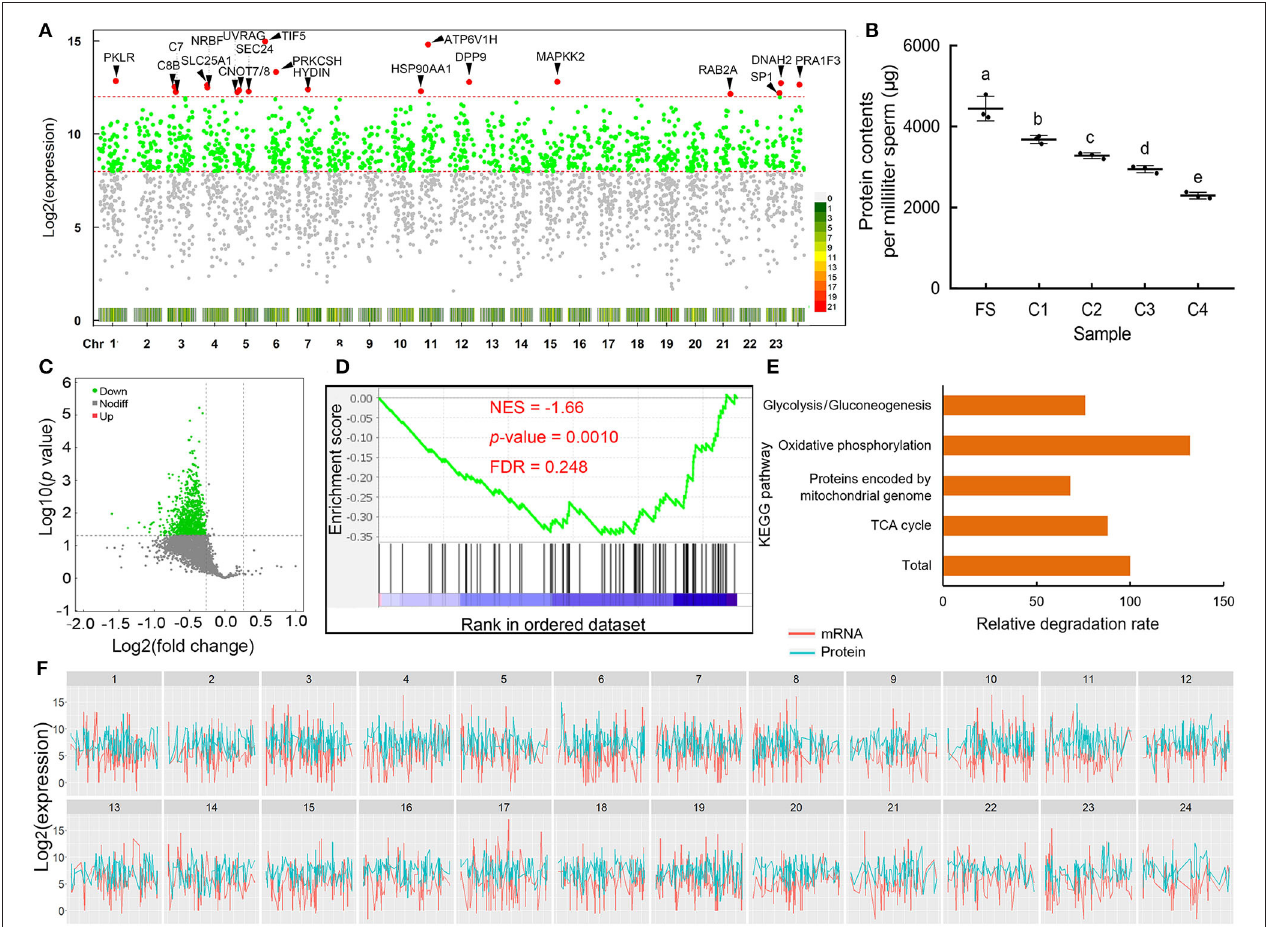
FIGURE 5 | The components and change of protein in sperm. (A) The distribution and density of sperm proteins. The red, green, and gray points indicate the highest expressed, high expressed, and low expressed proteins. (B) The changes of total protein contents in sperm during cold storage. (C) The volcano plot of proteins during storage; green points indicate the decreased proteins. (D) The enrichment of proteins related to oxidative phosphorylation. (E) Relative degradation rate of genes associated with energy metabolism. (F) The expression profiles of transcripts and proteins in sperm; green and red indicate proteins and transcripts, respectively. Different letters indicated significant difference ( p <